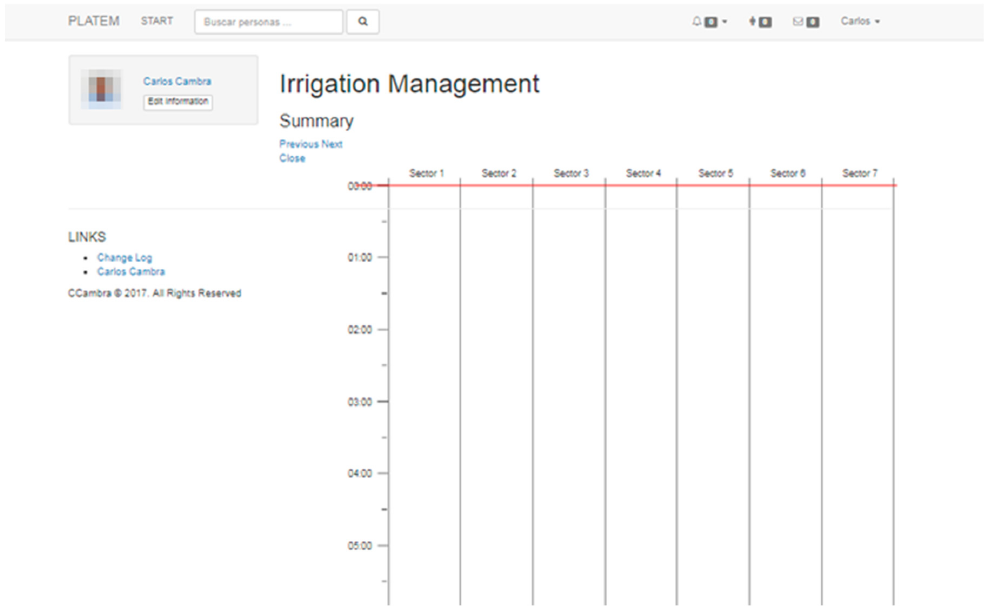
Figure 19. Historical water programs.